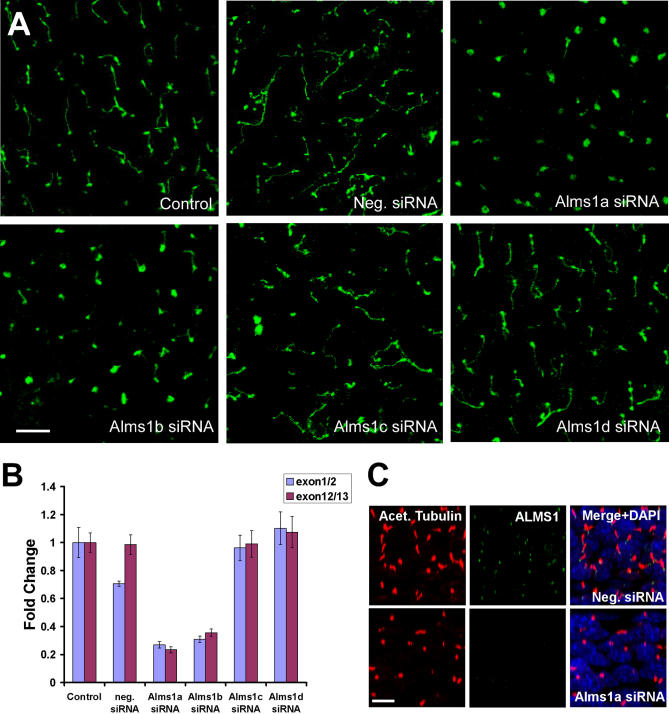
Suppression of Alms1 Expression Alters Primary Cilium Formation in Kidney Epithelial Cells(A) Elongated cilia, visualized with staining of acetylated tubulin (green), form normally in mIMCD3 cells after mock-transfection, transfection with a negative control siRNA, or transfection with two inactive siRNAs directed against Alms1 (Alms1c and Alms1d). Focal staining of acetylated tubulin without axoneme extension is seen after transfection with two active siRNAs targeting Alms1 (Alms1a and Alms1b).(B) Real-time PCR analysis with two mouse Alms1 probes recognizing the junctions of exons 1 and 2 and exons 12 and 13, respectively: Alms1a and Alms1b siRNAs both cause 70%–80% knockdown of Alms1 mRNA; no effect on Alms1 mRNA was seen with the three siRNAs that were inactive in the ciliogenesis assay.(C) Alms1a siRNA-treated cells lose endogenous Alms1 protein expression. Acet, acetylated. Scale bars, 10 μm.